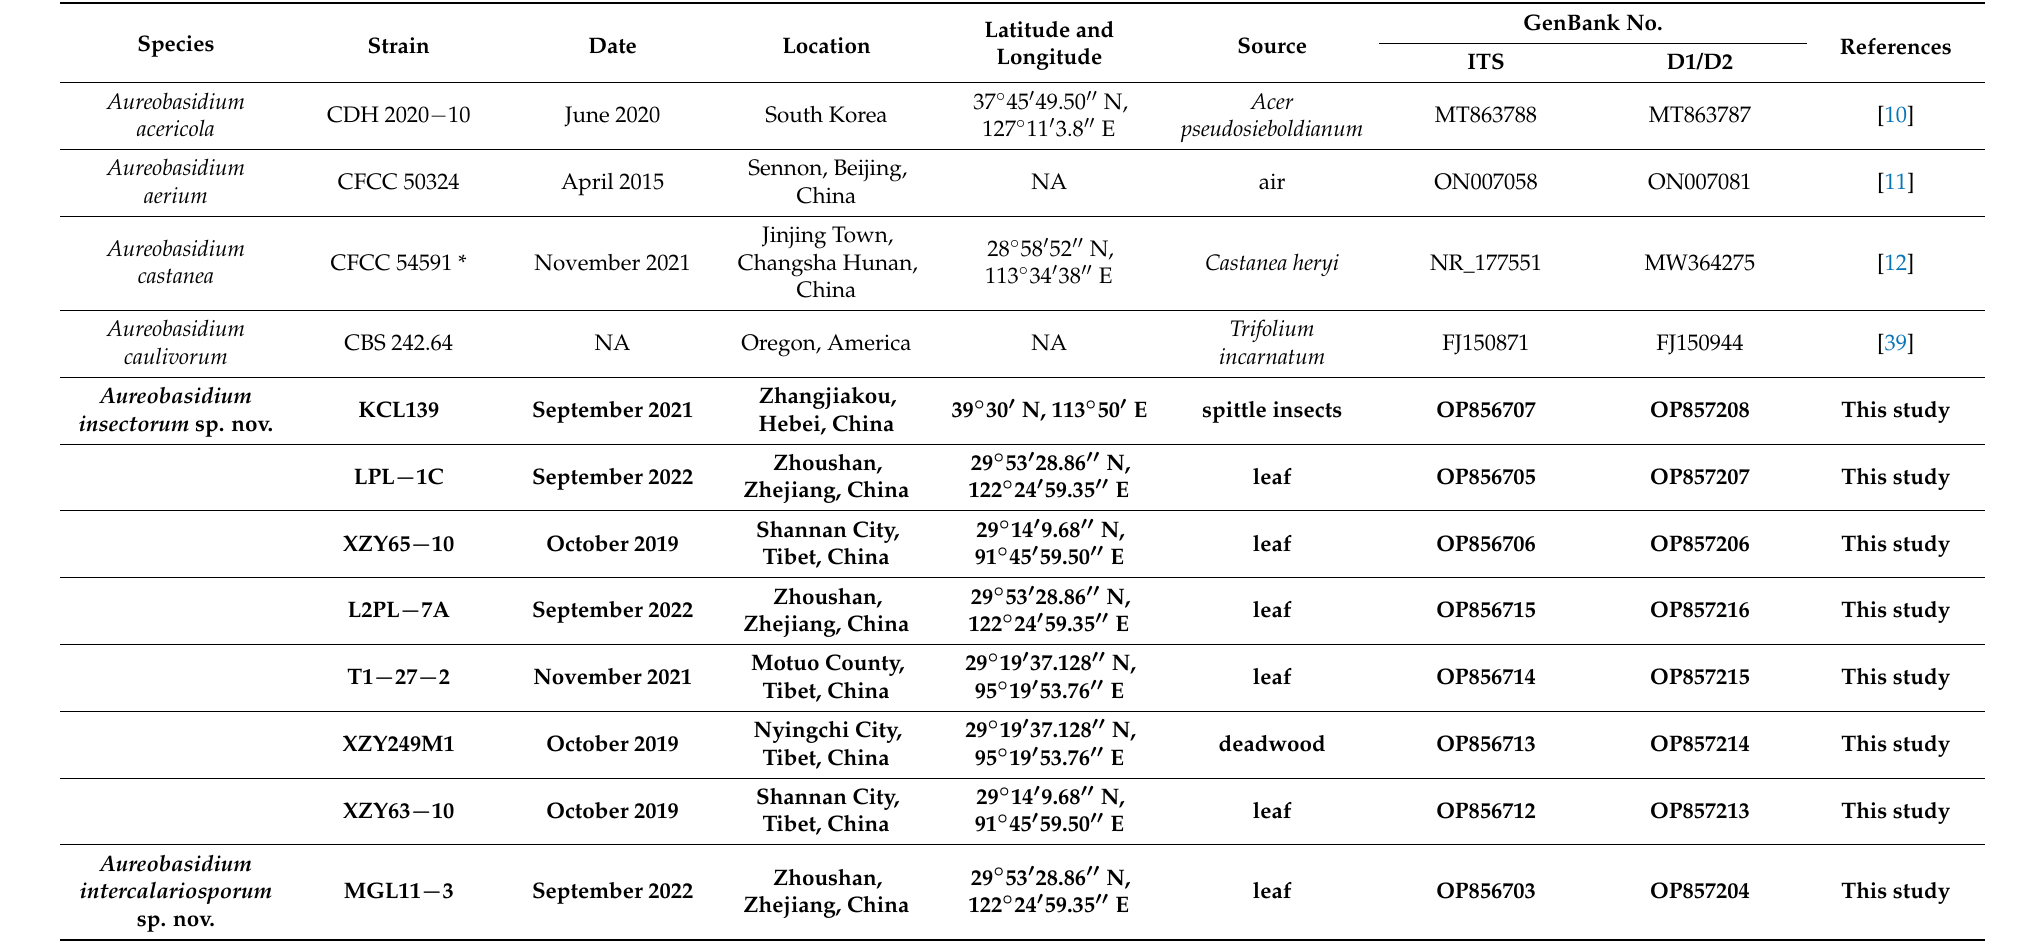
Table 1. Names, strains, locations, and hosts, and corresponding GenBank numbers of the taxa used in this